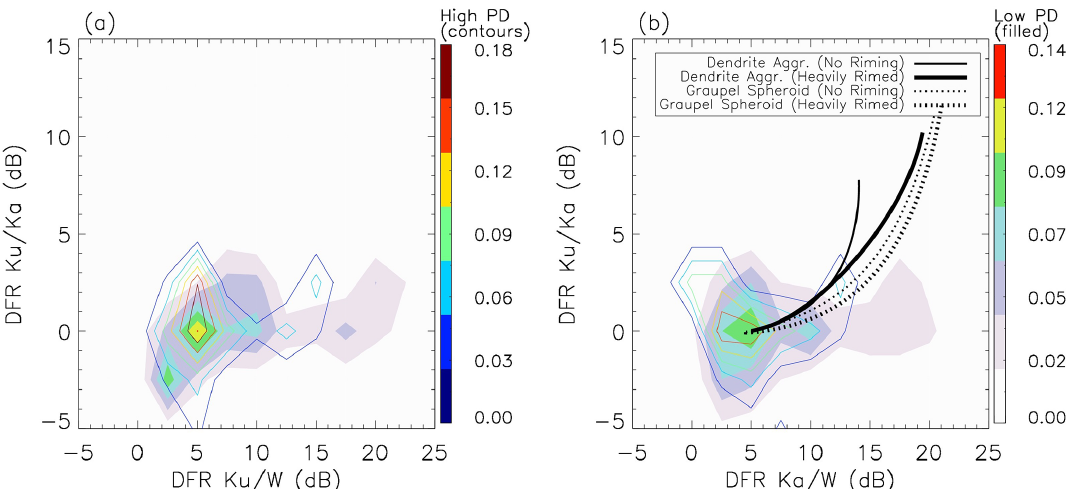
Figure 6. The 2D distribution of triple-frequency DFR diagram from the high-PD (dark rainbow-colored outlines) and low-PD (lighter colored shading) regimes composited from all collocated CloudSat and DPR observations: (a) DFR Ku / W versus DFR Ku / Ka ; (b) DFR Ka / W versus DFR Ku / Ka . The reflectivity observations are taken from the altitude range of 5.5–15km to minimize impacts from the melting layer or rain. Model-simulated dendrite (solid) and graupel spheroid (dotted) behaviors are overlaid on (b) for unrimed (thin) and heavily rimed (thick) cases. See Leoinonen and Szyrmer (2015) for model and ice morphology